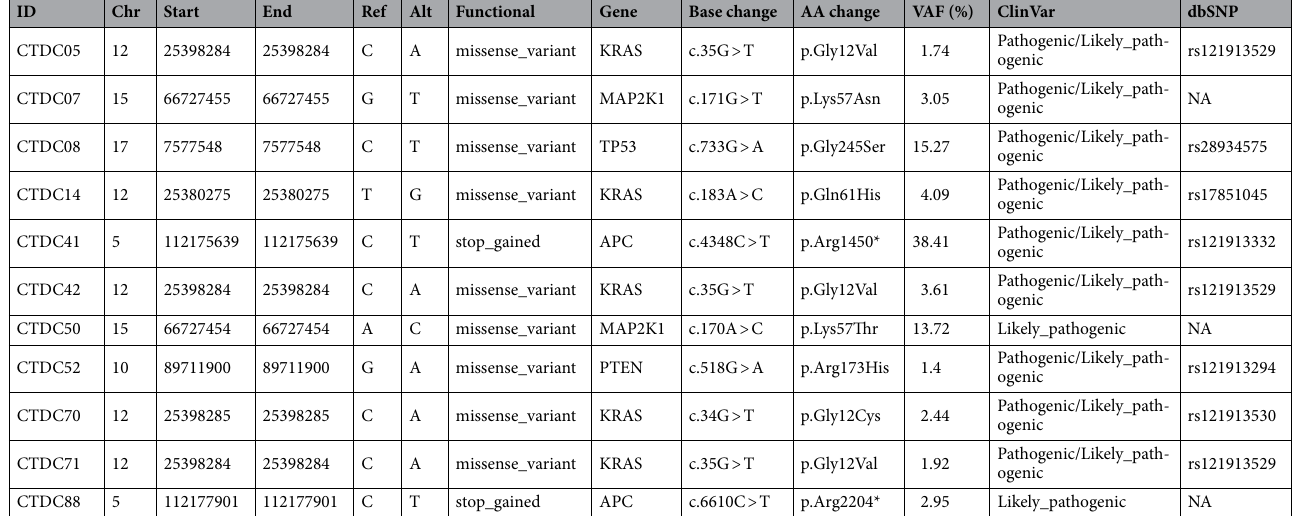
Table 4. List of candidate resistance mutations arisen during anti-EGFR treatment. The variants were previously known for pathogenic or likely pathogenic mutations by ClinVar